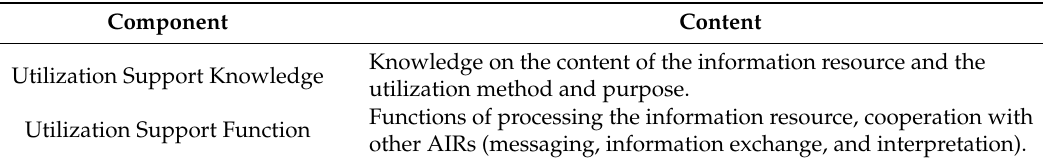
Figure 1. Architecture of an Active Information Resource (AIR). Table 1. Components of an Active Information Resource